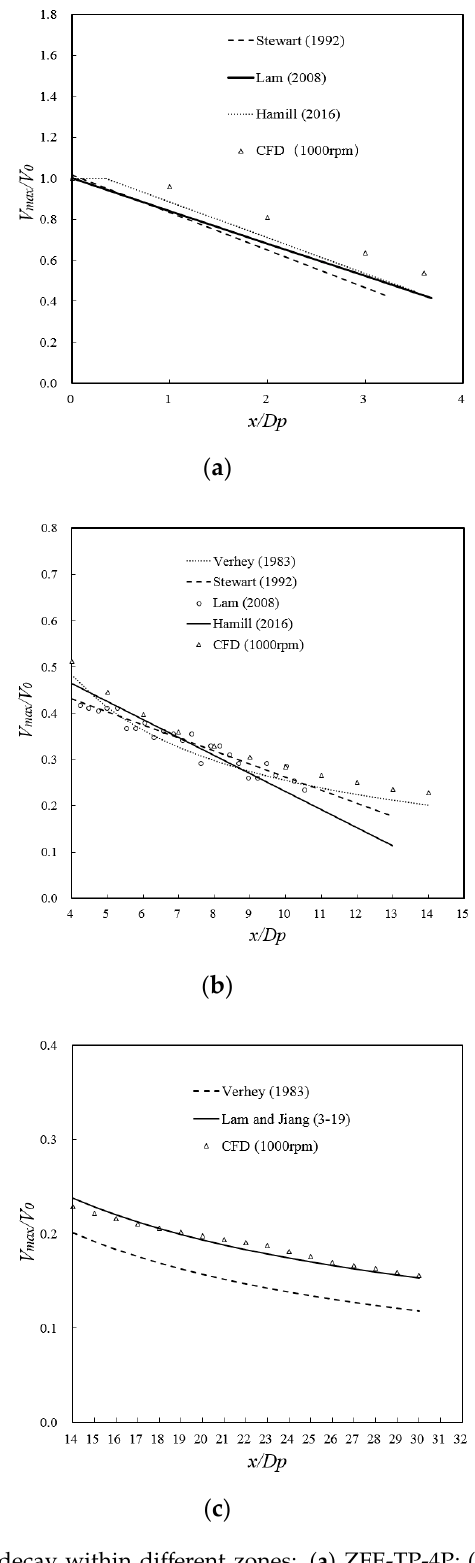
Figure 9. Axial velocity decay within different zones: ( a ) ZFE-TP-4P; ( b ) ZFE-TP-2P; ( c ) Zone of established flow.